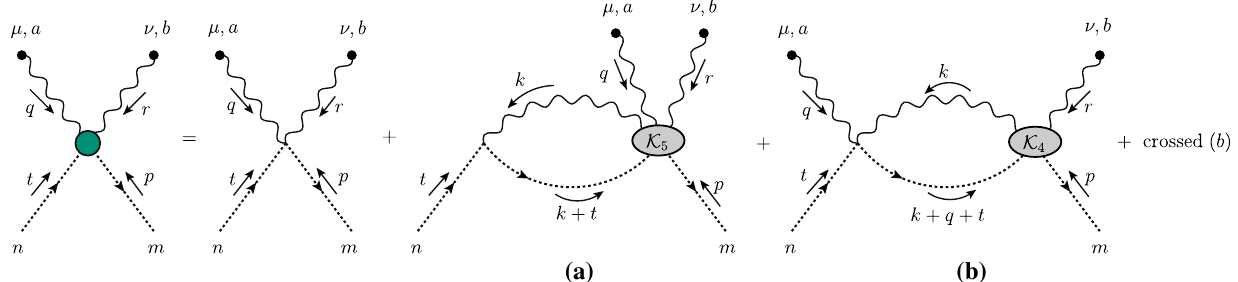
and K bcem , 4 μν 5 μνρ